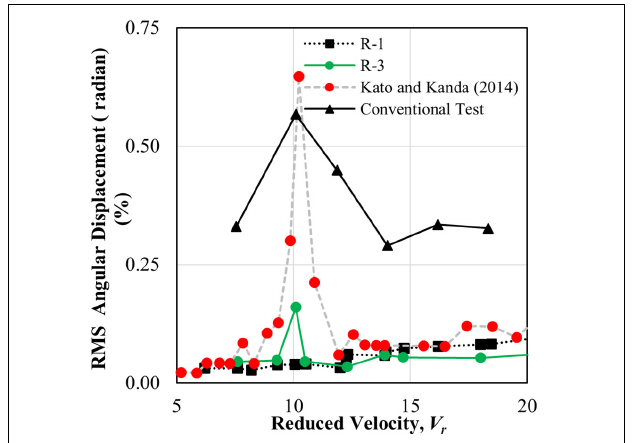
FIGURE 10 | Comparison of angular displacement from RTAHS, conventional aeroelastic tests, and Kato and Kanda (2014).